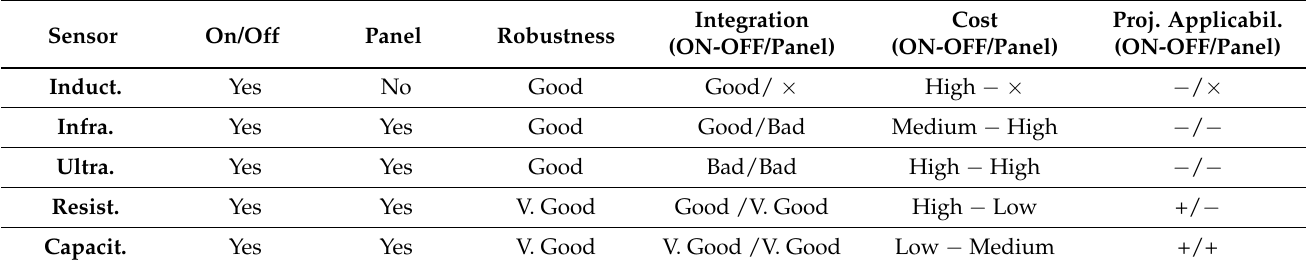
Table 1. Summary of the characteristics of the different technologies covered and investigated under the context of project SmartPlastic .